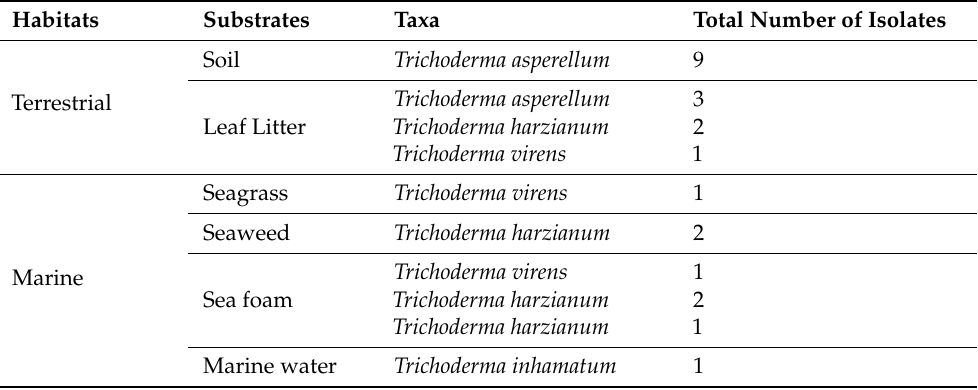
Table 1. Trichoderma isolated from marine and terrestrial substrates collected from Luzon Island,